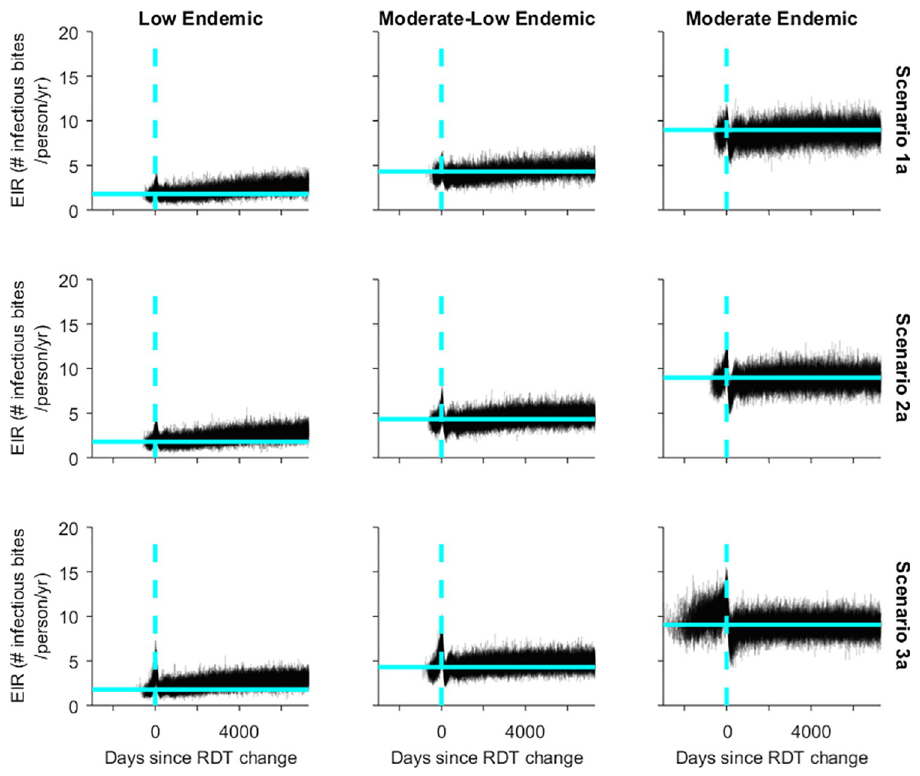
Fig 6. Simulation trajectories for EIR in a village where 50% of symptomatic patients seek diagnosis and treatment and a Pf-pLDH RDT is used after the RDT change. Vertical dashed line: RDT change day; light blue horizontal line: 75 th percentile of EIR in the 500 days before introduction of HRP2-negative parasite.